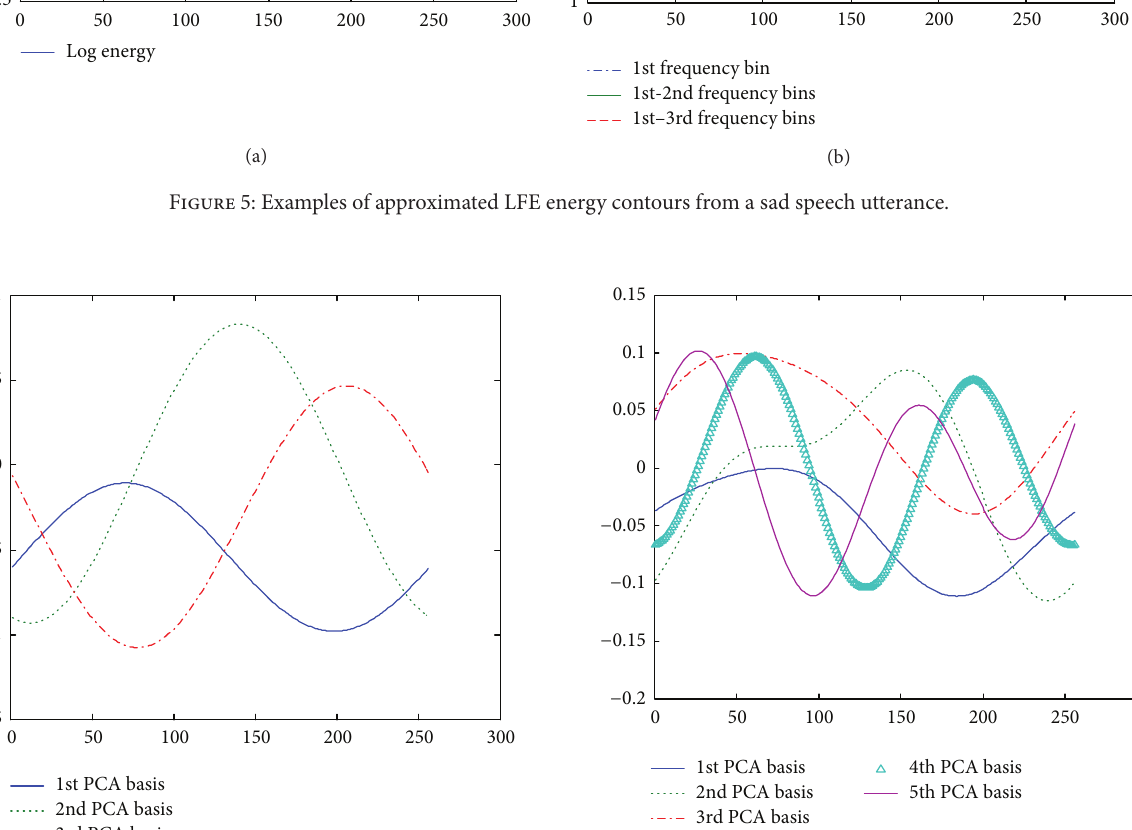
Figure 6: PCA bases of approximated LFE with 𝑚 value being 1.